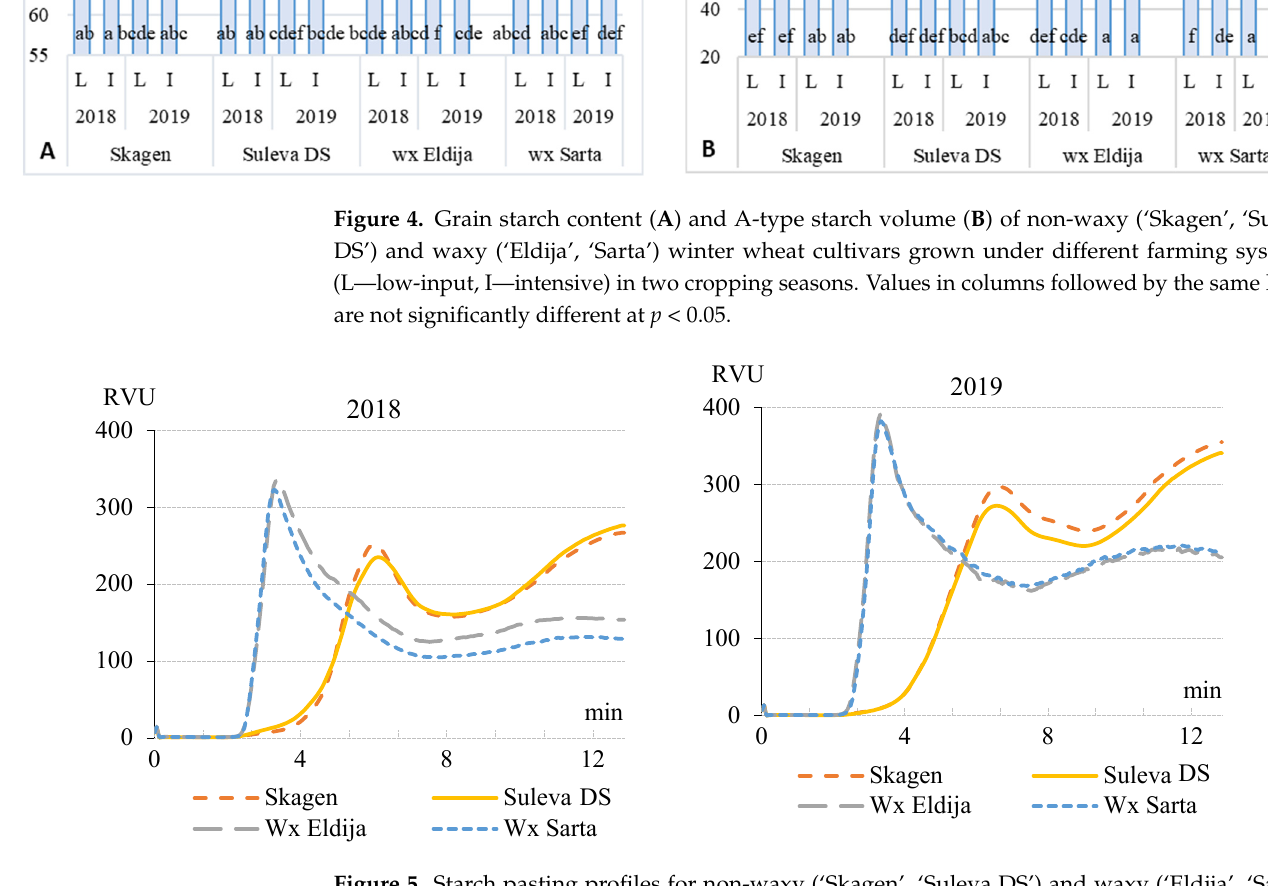
Figure 5. Starch pasting profiles for non-waxy (‘Skagen’, ‘Suleva DS’) and waxy (‘Eldija’, ‘Sarta’) wheat cultivars grown over two cropping seasons (averaged data of two farming systems). Analysis performed with RVA—rapid visco analyzer; RVU—rapid visco units.